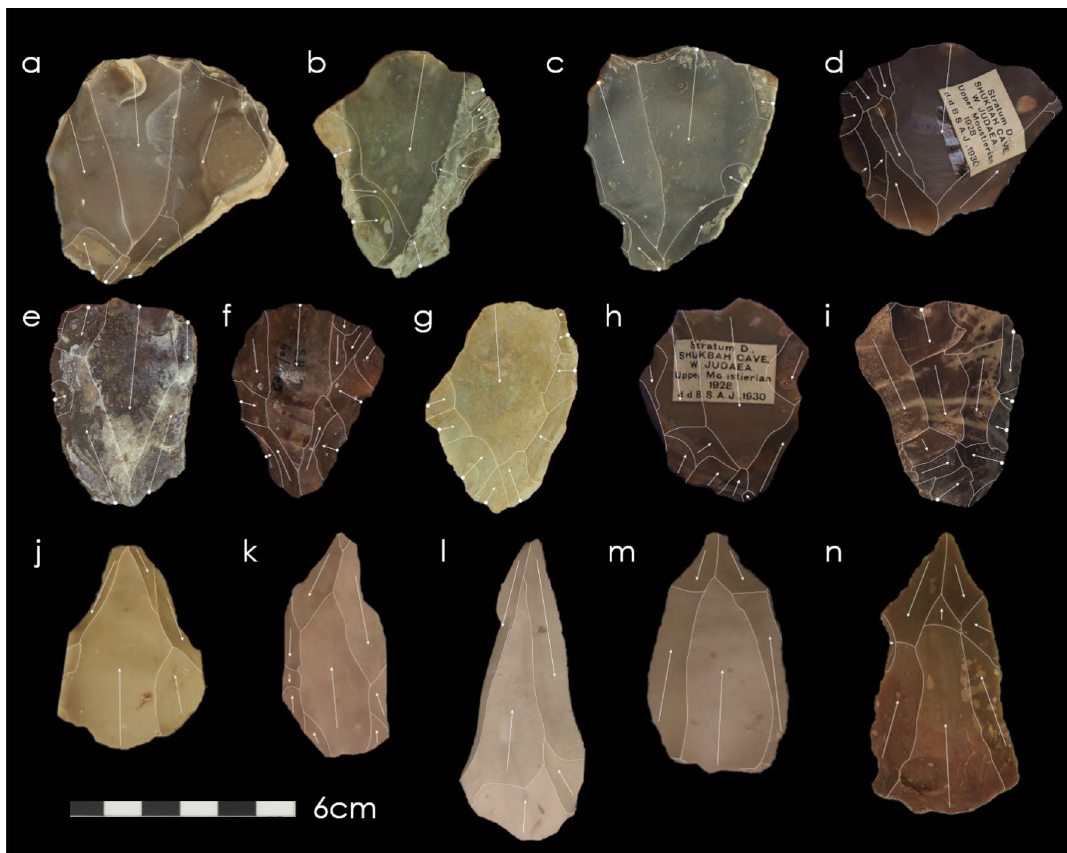
Figure 5. Nubian Levallois cores from Shukbah Cave ( a – h ) and Bisitun ( i ) and Nubian Levallois points from Shukbah cave ( j – n ) which feature a medial distal ridge through distal divergent and/or bilateral shaping. ( a – c